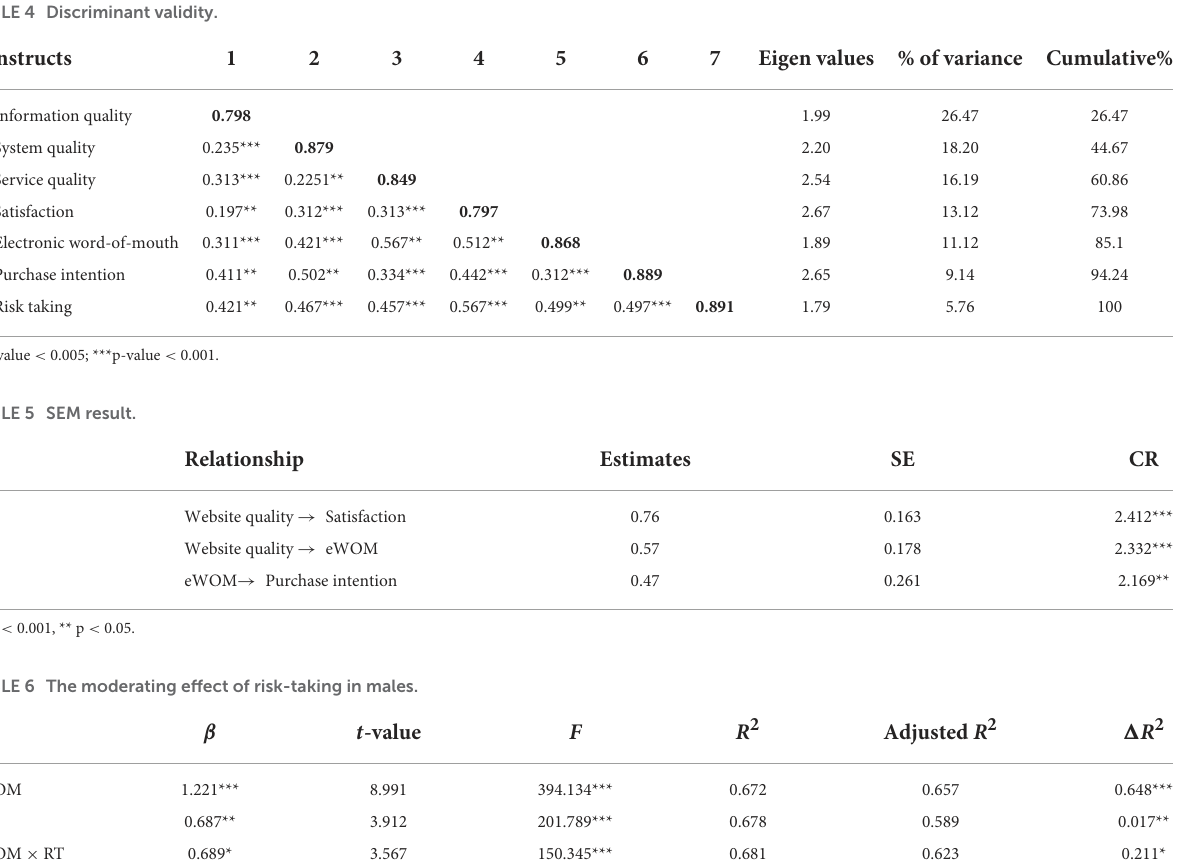
TABLE 4 Discriminant validity.